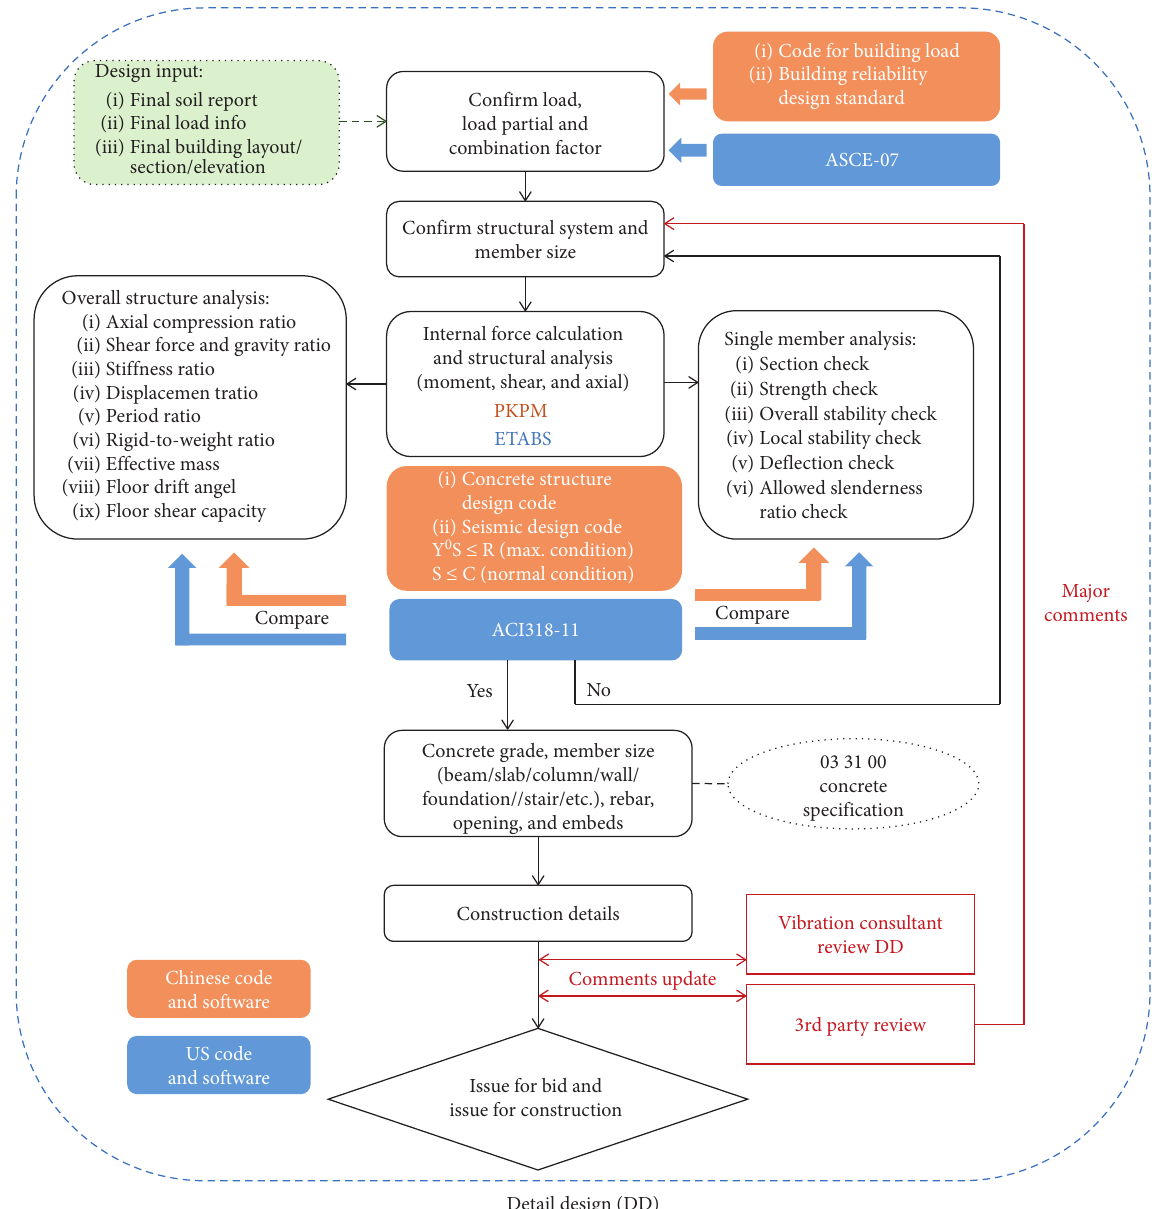
Figure 2: Comparison of construction design processes of the Chinese and American